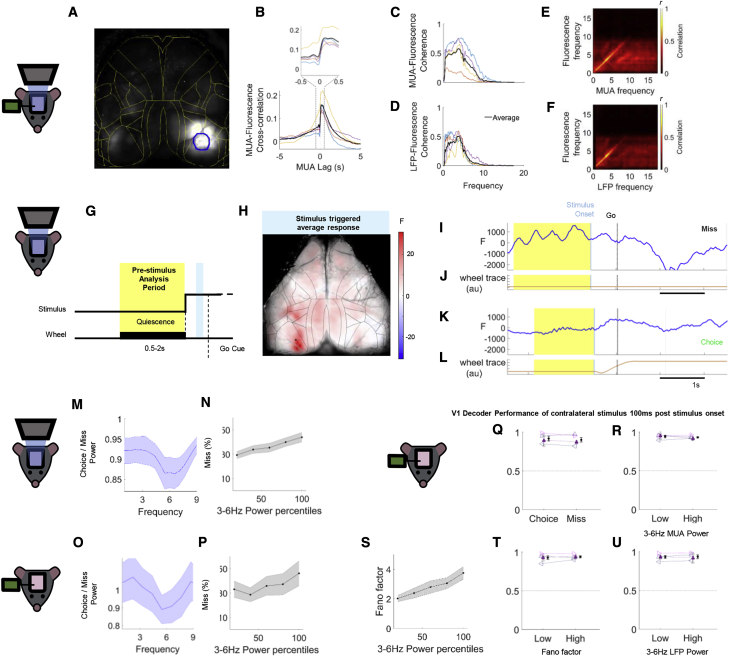
Engagement Correlates with Decreased Low-Frequency Power in Visual Cortex(A) Pseudocolor representation of the regression weights optimally predicting spikes from fluorescence. Yellow lines: cortical area borders from the Allen atlas. Blue circle: Neuropixels probe location, from which the fluorescence signal used in (B)–(F) was obtained.(B) Cross-correlation between multiunit activity (MUA) and fluorescence in visual cortex. Inset: zoom-in to the time period indicated by the dashed lines (bottom).(C) Coherence between MUA activity and fluorescence. Each colored curve represents one mouse; the thick black curve indicates their average.(D) Coherence of local field potential (LFP) and fluorescence.(E) Average cross-frequency correlation between instantaneous MUA and fluorescence powers.(F) Same as (E) but with LFP instead of MUA power.(G) Schematic indicating pre-stimulus (quiescent period; yellow) and stimulus response (blue; 70–80 ms after stimulus onset) analysis periods. All trials started with a baseline of 1–5 s, during which animals had to remain quiescent for 0.5–2 s to initiate the appearance of a stimulus. After the stimulus appeared, a Go cue signaled the start of the response window. If the animals did not make a choice within the response window (1.5–5 s), a No-Go or Miss response was recorded.(H) Pseudocolor representation of average fluorescence in a stimulus response window after presenting high-contrast visual stimuli in the right visual field. Black lines: cortical area borders from the Allen atlas. The black dot in the left hemisphere indicates a pixel chosen for analysis of visual cortical power.(I–L) Single-trial calcium traces from representative Miss (I and J) and Correct Choice (K and L) trials. Yellow background indicates a quiescent period, during which there was no stimulus present and the animals held the wheel still. Light blue vertical line indicates stimulus onset; gray vertical dashed line indicates the Go cue (start of the response window). The brown traces below the blue fluorescence traces indicate the wheel movements.(M) Ratio of visual cortical power spectra in Choice versus Miss trials in visual cortex, averaged over all experiments (n = 58 experiments from 15 animals; see STAR Methods). Shaded areas indicate SEM.(N) Percent of Miss responses as a function of 3- to 6-Hz power.(O and P) Same analysis as in (M) and (N) for MUA power in animals performing the same tasks with electrophysiology recordings (n = 11 experiments from 4 animals).(Q and R) Performance of a logistic regression decoder trained on primary visual cortical population activity to detect the presence of a contralateral stimulus. There were no significant differences in decoder performance between Choice and Miss trials (Q), or low and high 3- to 6-Hz power in MUA (R) trials (p > 0.05; n = 5 experiments from 4 animals). Color indicates genotype; different glyphs indicate different animals. For one of the animals there were two sessions; the individual sessions are indicated in light gray; the colored glyph indicates their average. Dashed lines connecting two glyphs indicate paired experiments; the dashed line at 0.5 indicates chance-level decoding.(S) Noise correlations, as inferred from the Fano factor of summed population activity, increase with increasing 3- to 6-Hz MUA power.(T and U) There was no significant difference in decoder performance between trials with low or high Fano factor (T) or low or high 3- to 6-Hz LFP power (U) (p > 0.05).See also Figures S1–S3.